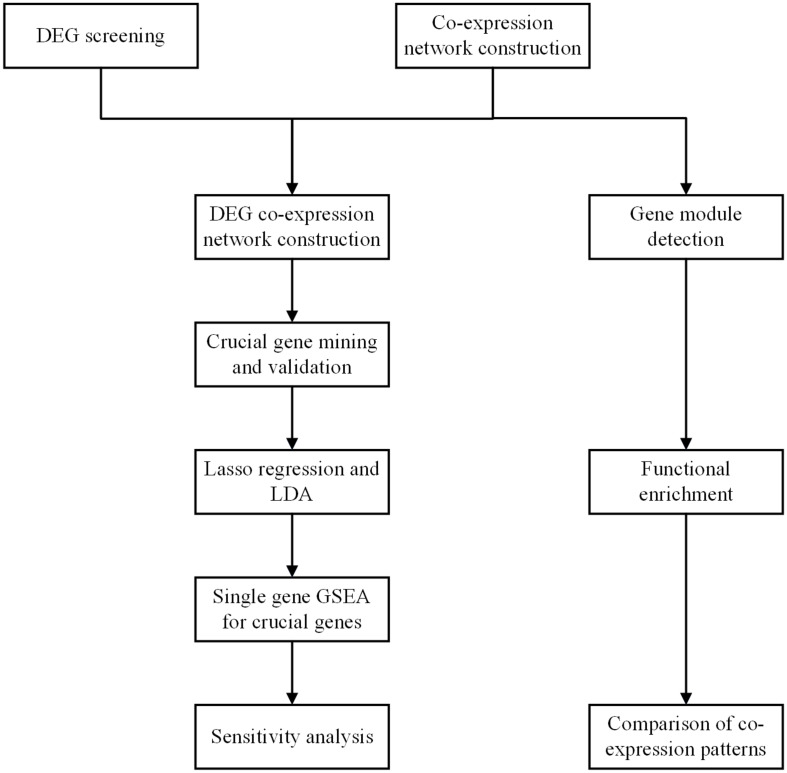
Workflow of the whole study.